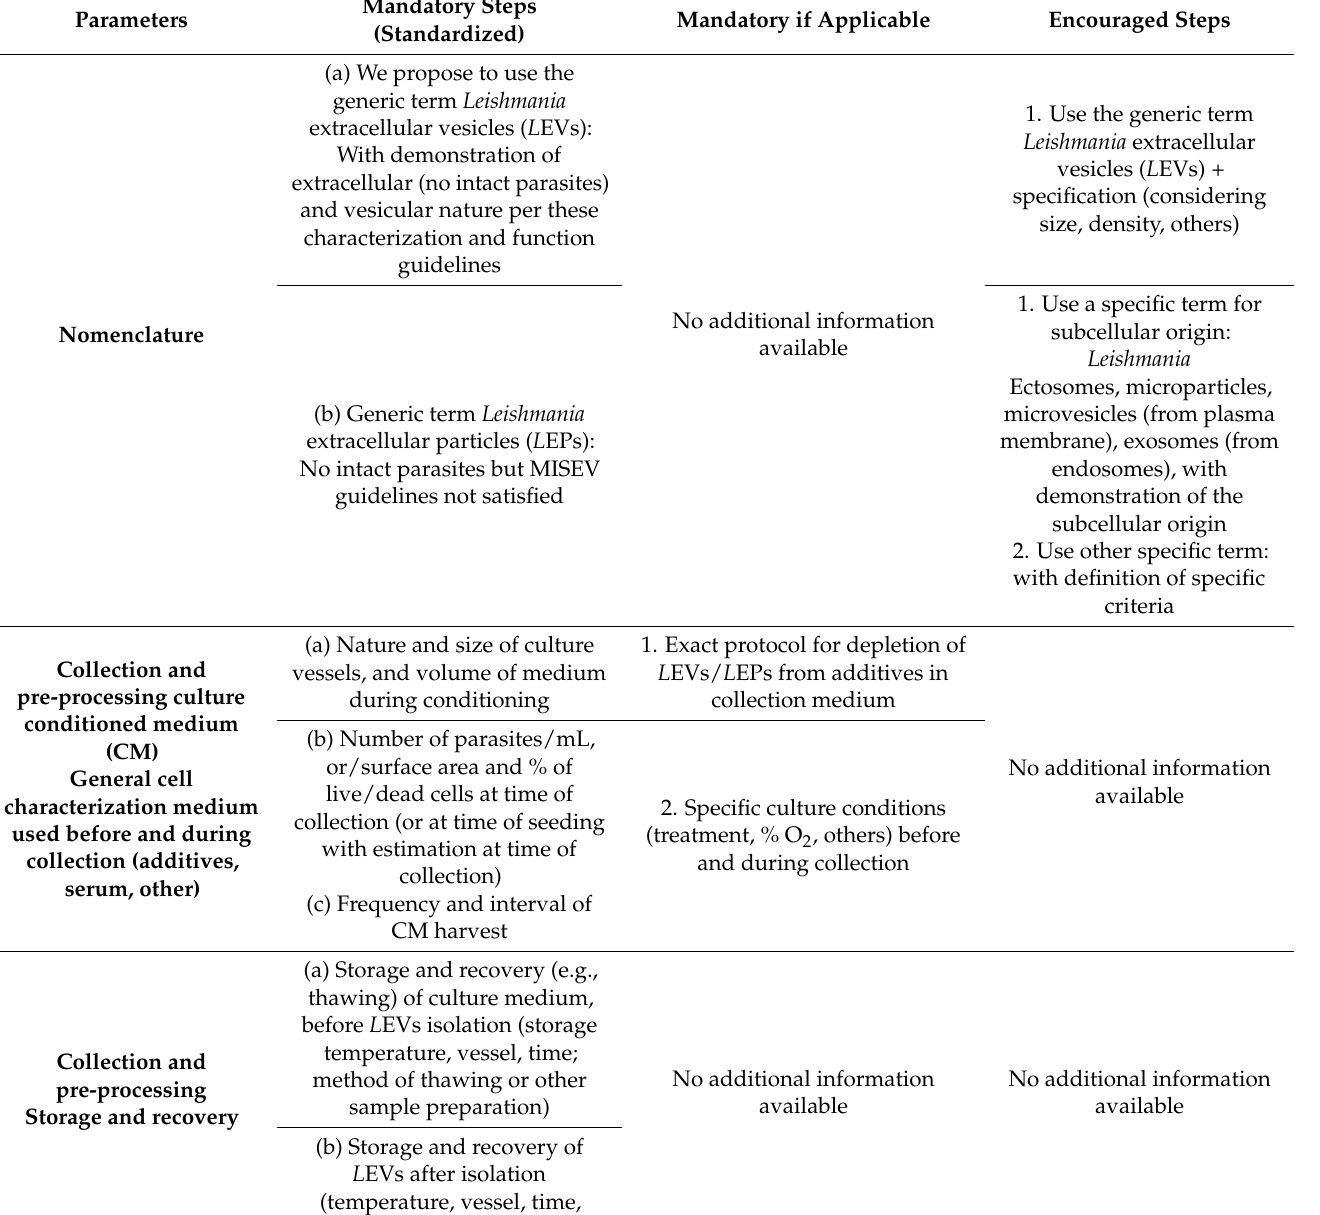
Table 2. Checklist for Leishmania extracellular vesicles ( L EVs) research [87,88].